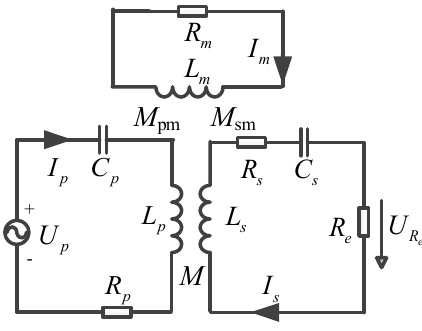
Figure 2. Equivalent circuit.